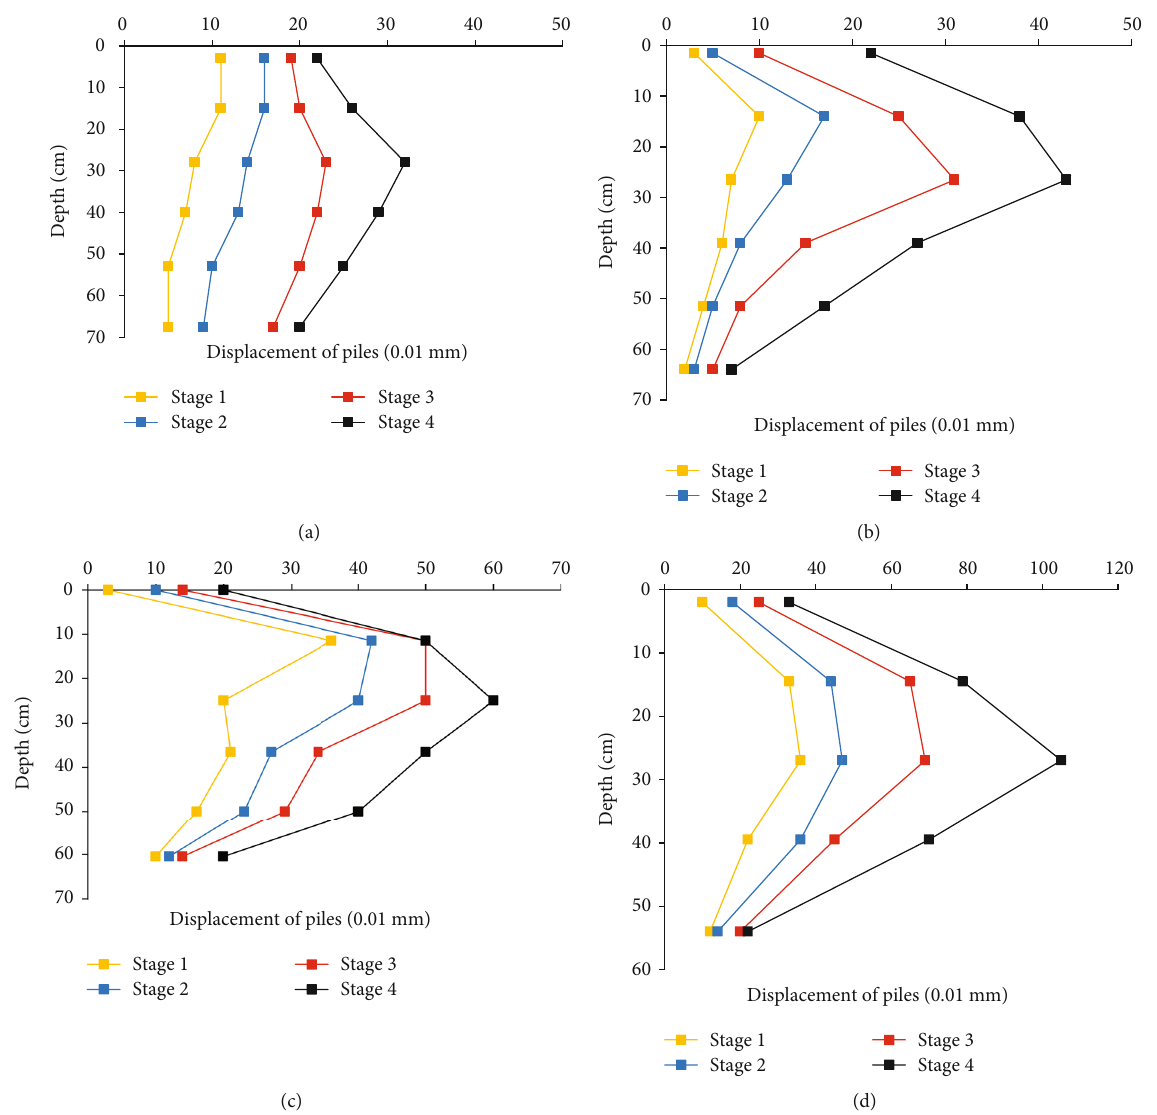
Figure 13: (a) Pile displacements of 0.41H; (b) pile displacements of 0.33H; (c) pile displacements of 0.27H; (d) pile displacements of